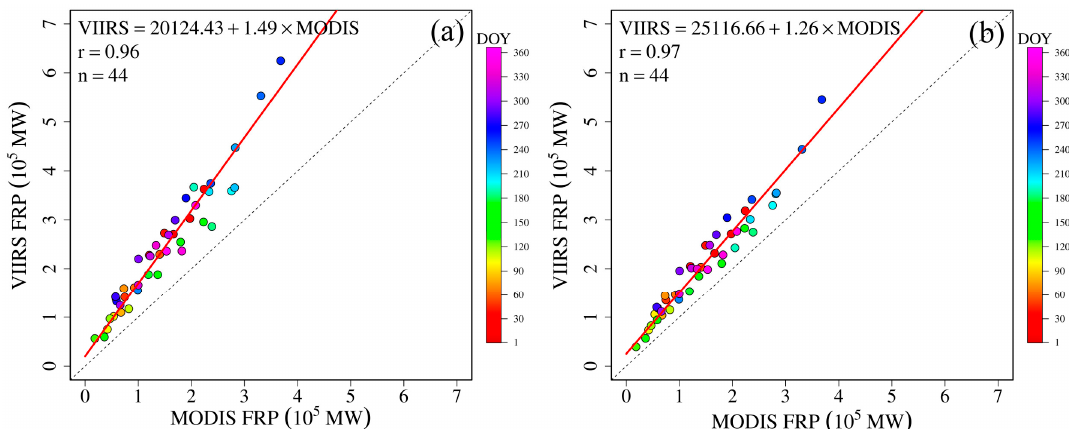
Figure 5. Comparison of daily continental sum FRP from daytime active fire detections observed contemporaneously by MODIS and VIIRS I-band across Africa in 2017. ( a ) MODIS FRP versus VIIRS FRP from all VIIRS fire detections, and ( b ) MODIS FRP versus VIIRS FRP inside MODIS granules (VIIRS detections in swath gaps were excluded). The color legend on the right represents the date (day of year, abbreviated as DOY) of each sample observation. The red solid line represents the best-fitted model line and the dashed line is the 1:1 line.